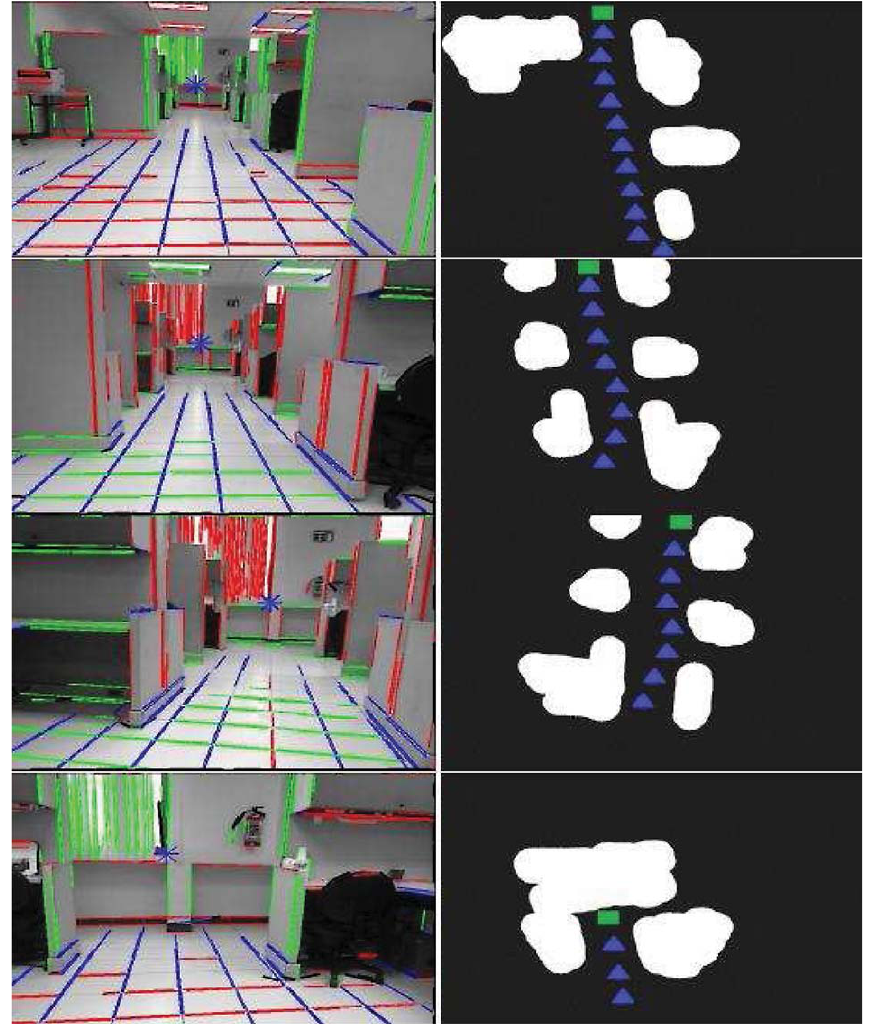
Fig. 6. Sequence of the computation of the point at infinity at front during motion of the guidance